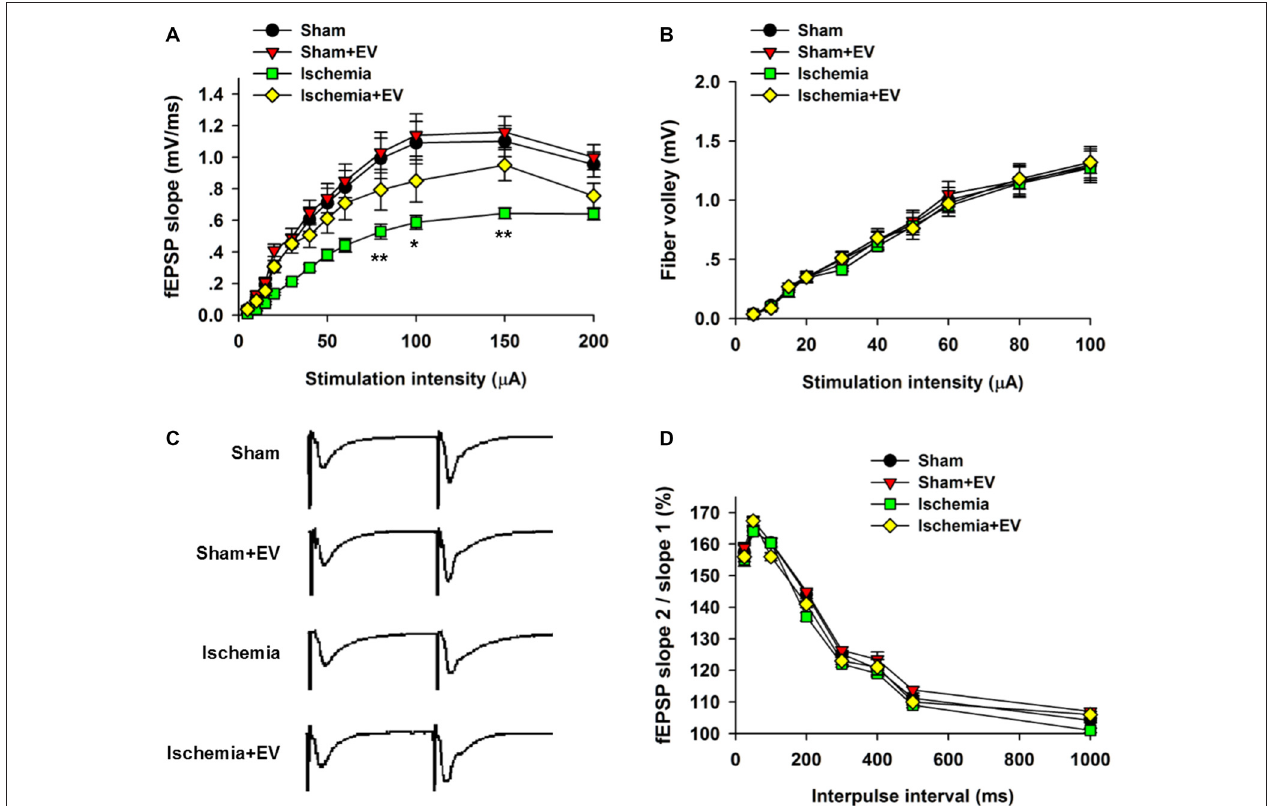
FIGURE 3 | Effects of ischemia and BMSC-EVs on basal properties of excitatory synaptic transmission in animals subjected to global ischemia. (A) Input-output (I/O) ratios of field excitatory post-synaptic potentials (fEPSPs) slope at Schaffer collateral to CA1 synapses were recorded from stratum radiatum in acute hippocampal slices (80 µ A: sham = 0.99 ± 0.13, sham + EV = 1.03 ± 0.13, ischemia = 0.53 ± 0.05, ischemia + EV = 0.80 ± 0.12; 100 µ A: sham = 1.10 ± 0.14, sham + EV = 1.15 ± 0.15, ischemia = 0.59 ± 0.04, ischemia + EV = 0.85 ± 0.14; 150 µ A: sham = 1.10 ± 0.12, sham + EV = 1.16 ± 0.11, ischemia = 0.65 ± 0.04, ischemia + EV = 0.95 ± 0.11). (B) Fiber volley amplitude were recorded as a function of stimulus intensity. (C,D) BMSC-EVs does not alter release probability in mice subjected to global ischemia. fEPSPs evoked by paired pulse stimulation of Schaffer collaterals at 25, 50, 100, 200, 300, 400, 500 and 1000 ms were recorded. (C) shows representative fEPSP traces with 100 ms of inter-pulse interval. n = 15 neurons from four mice per group. Data show means ± SEM. Two-way ANOVA analysis followed by a Tukey’s post hoc test. ∗ p < 0.05, ∗∗ p < 0.01.